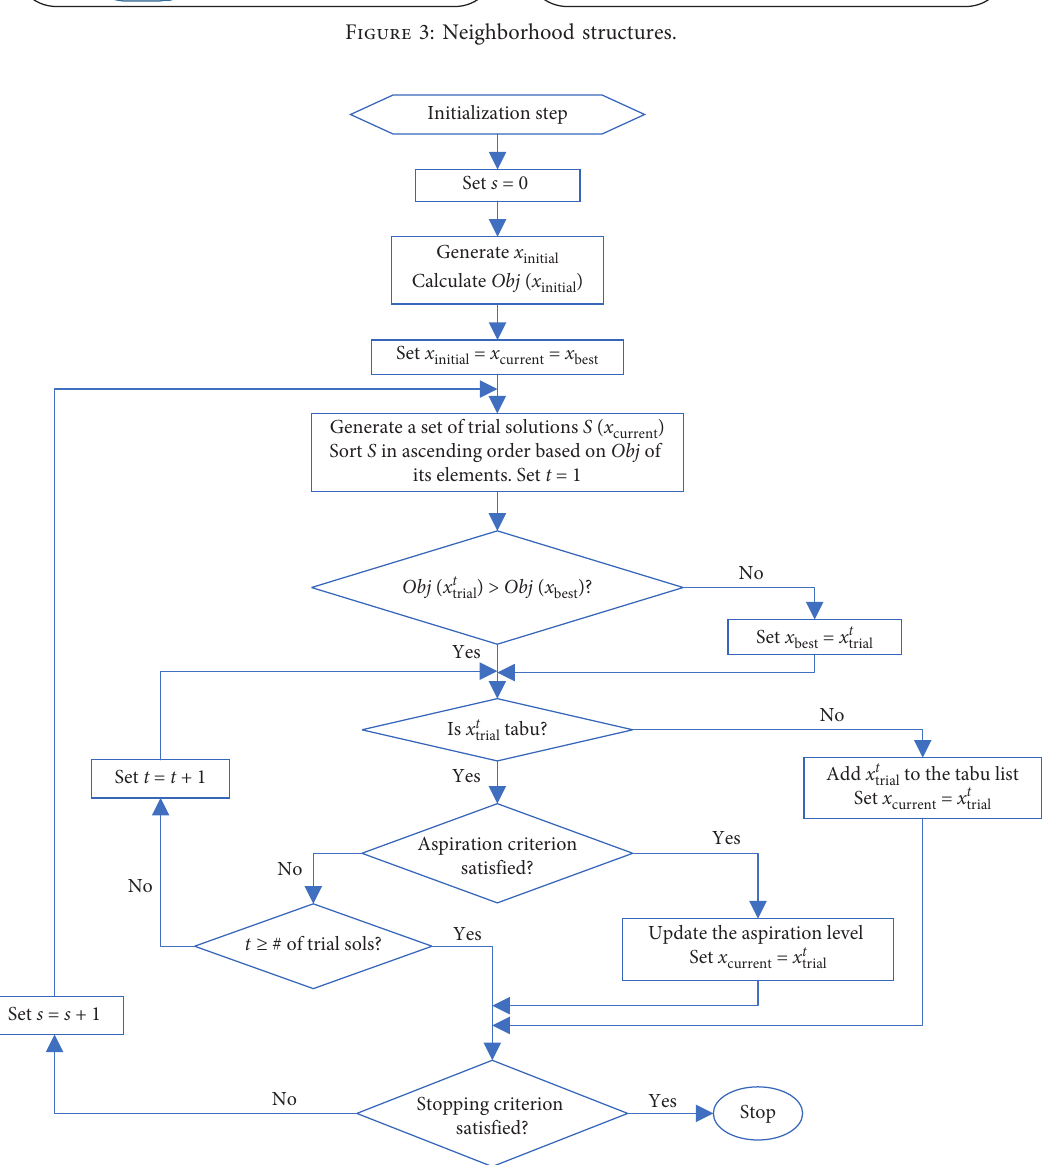
Figure 4: The computational flow of the TS algorithm.